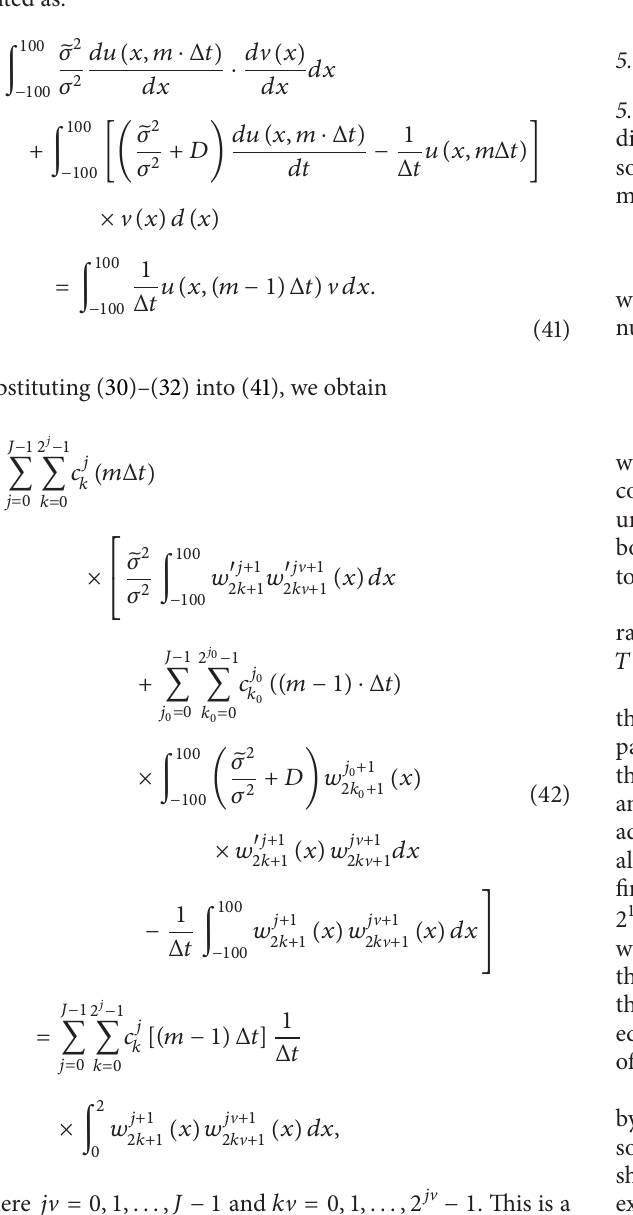
Figure 1: Initial condition of Black-Scholes